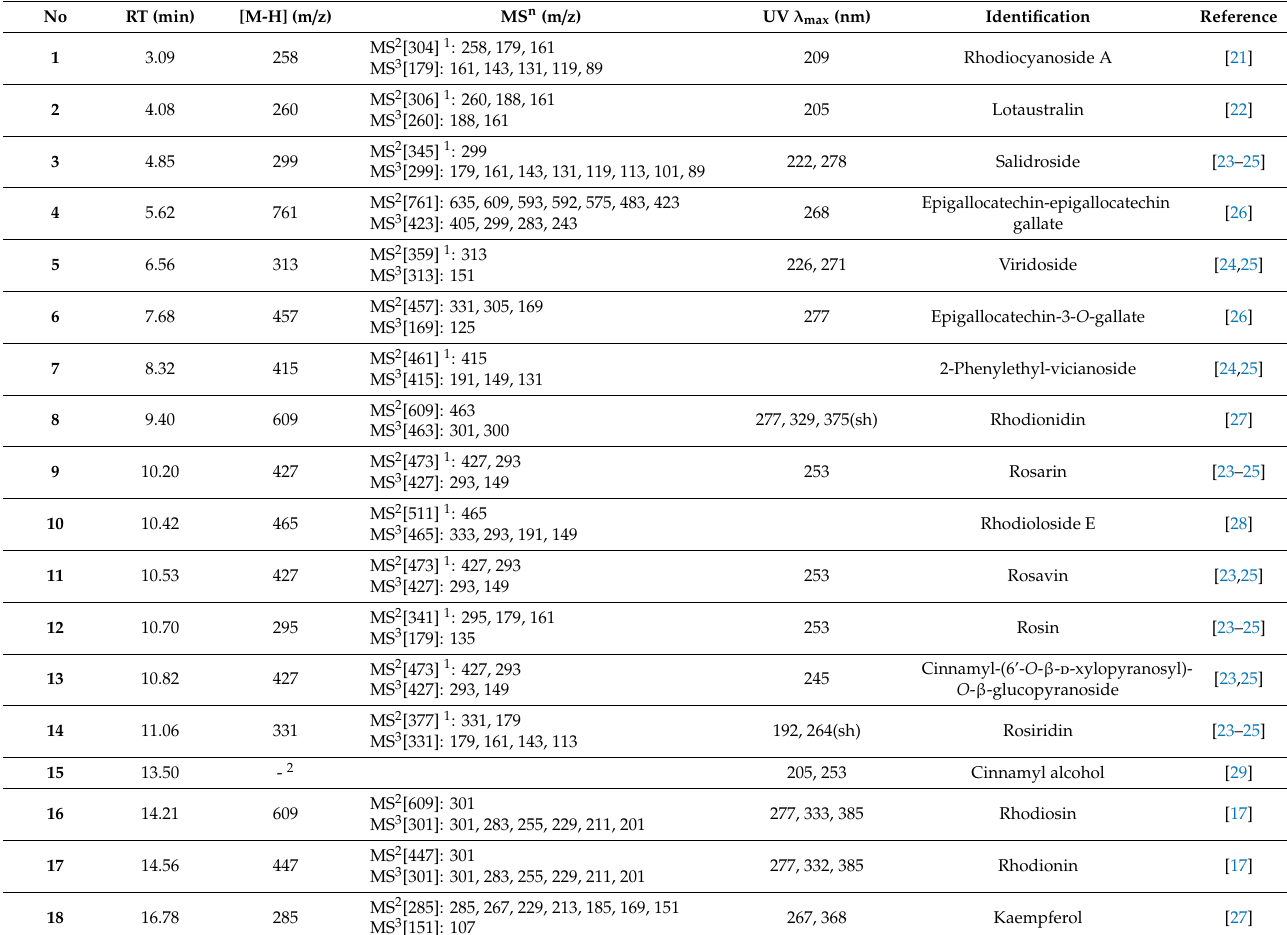
Table 2. Qualitative analysis of Rhodiola rosea rhizome accelerated solvent extraction (ASE) extract from collection site Gurktal Alps; rhizomes were collected during flowering